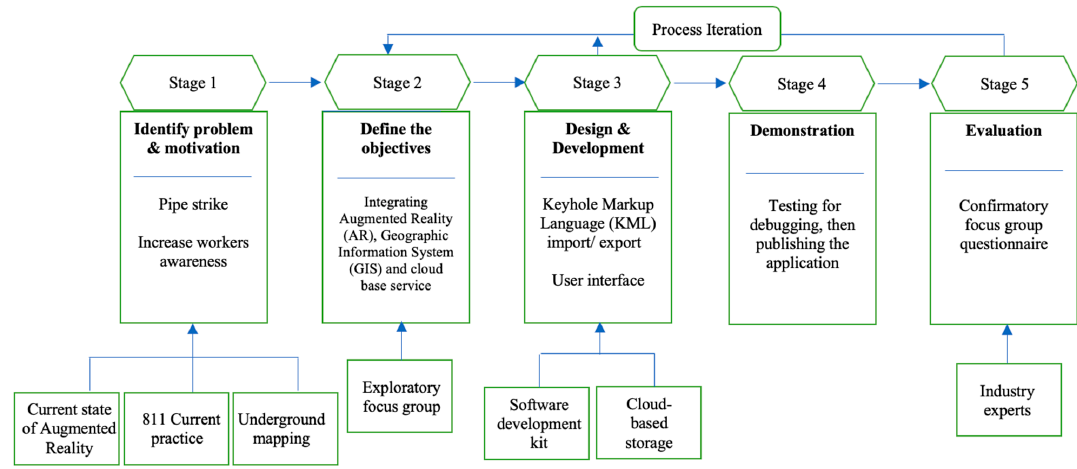
Figure 2. Design science research approach.